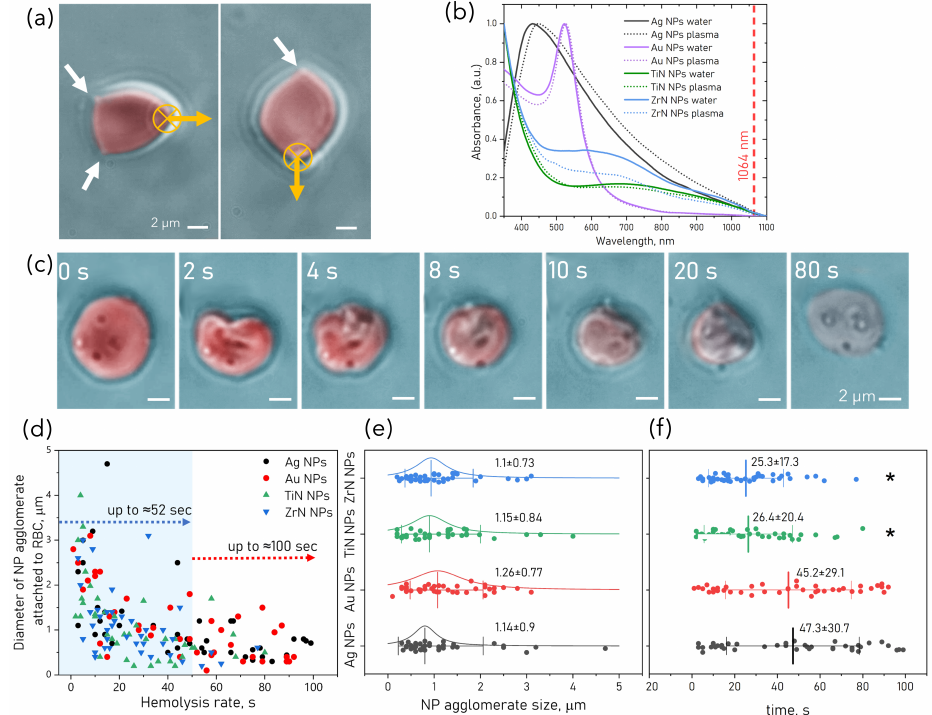
Figure 5. ( a ) RBC treated with ZrN ( left ) and TiN ( right ) NP adhered to the bottom of the measure- ment chamber. Regions of RBC stuck to the bottom are shown with arrows. Optical trap at maximum power 180 mW (55pN) was unable to trap RBC. ( b ) Normalized absorption spectra of NP dispersions in water and blood plasma. ( c ) Camera snapshots during 80s of photothermal destruction of RBC with attached Au NP clusters indicated by arrows in a laser trap (power 40mW). RBC becomes pale as the optical contrast decreases due to hemolysis. ( d ) Scatter plot of laser trap time exposure vs. size of NP aggregates. The shadowed area indicates the maximum time required to destruct an RBC with attached TiN and ZrN NP. Scatter interval plots (one-way-ANOVA, post hoc Tukey’s test, n = 40, comparisons with significant differences are marked for * p < 0.05) of mean ± SD for NP agglomerate sizes ( e ) and time of RBC destruction ( f